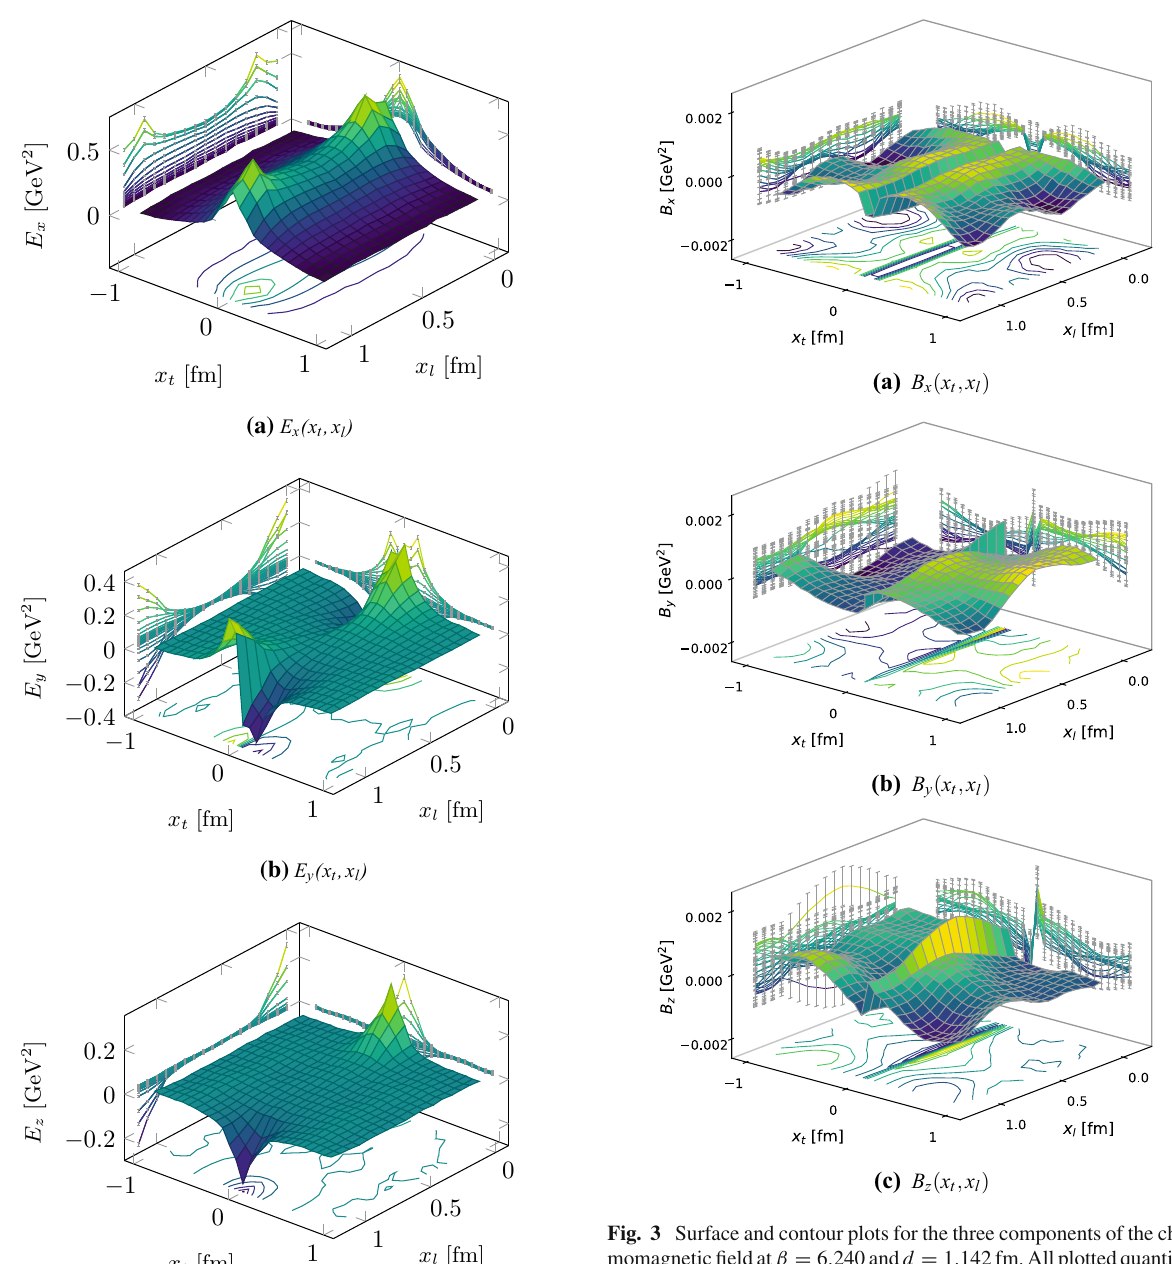
at different blocking levels. We set the physical scale for the √ σ = 420 MeV for the lattice spacing by using the value √ σ that string tension, and the parameterization [37] for a gave an accurate fit in a high-statistics simulation for all β in the range 5 . 6 ≤ β ≤ 6 . 5. The correspondences between β and the distance d shown in Table 1 were obtained from this parameterization. Note that the distance in lattice units between quark and antiquark, corresponding to the size of the Wilson loop in the connected correlator in Eq. (1), was kept fixed to d = 16 a